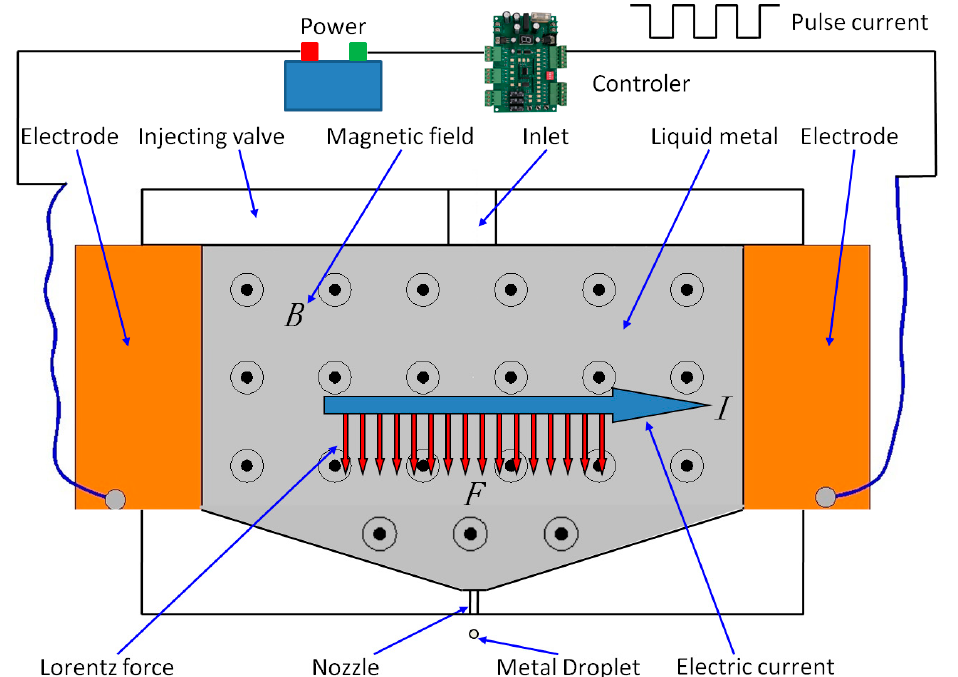
Figure 1. Schematic illustration of electromagnetic micro-jetting (EMJ).